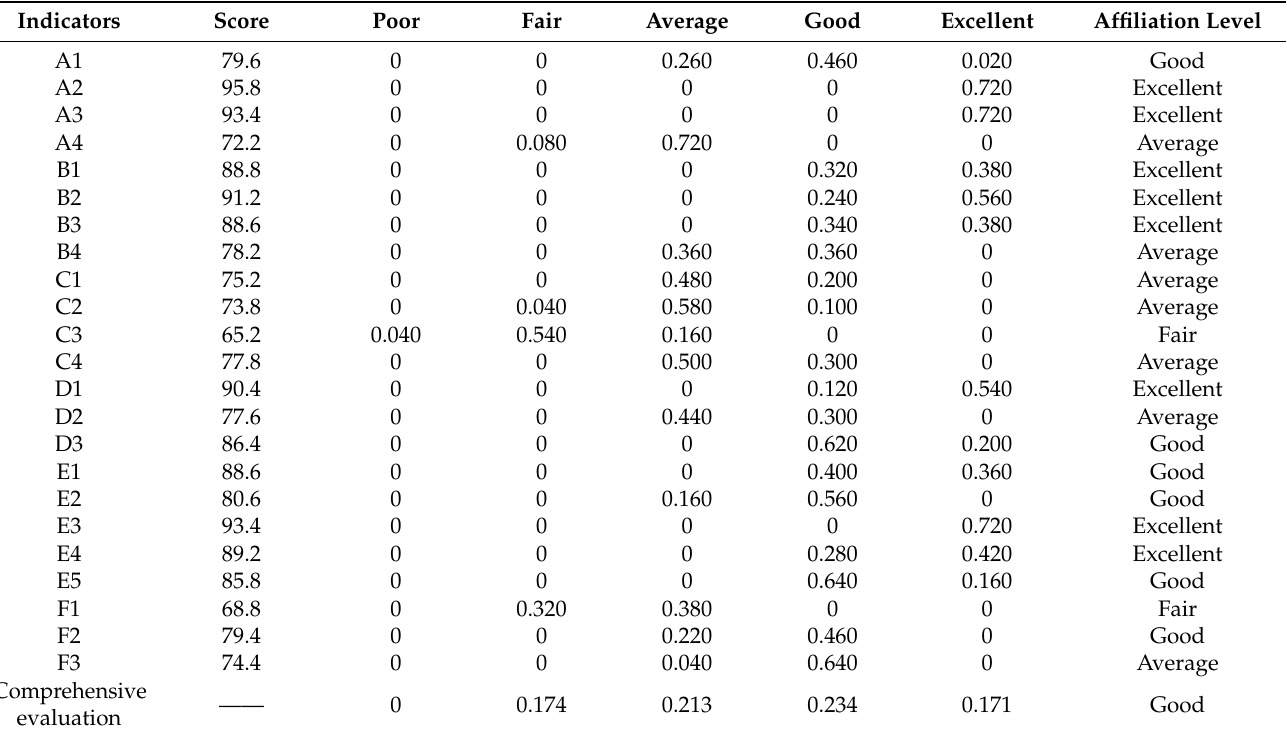
Table 4. Port B Qinzhou Collection Division CTOS construction performance evaluation